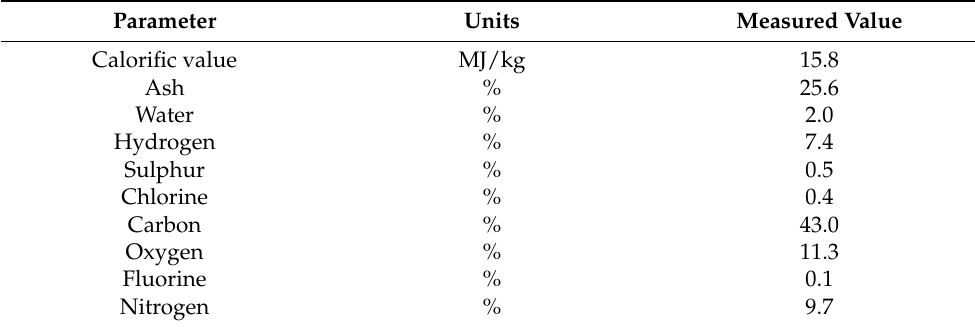
Table 1. Chemical analysis of meat and bone meal processed in the tested facility.